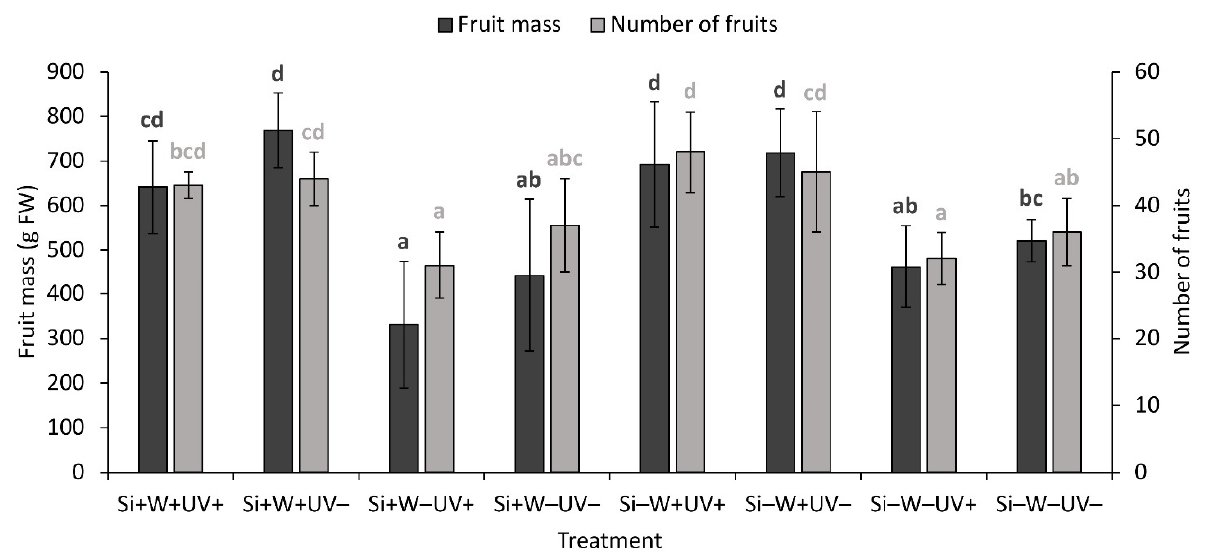
Figure 4. Fruit mass and number of fruits for cucumber plants, grown under the eight different treatments ( n = 85). Different letters indicate significant differences between the treatments for each of the two parameters separately. FW, fresh weight.